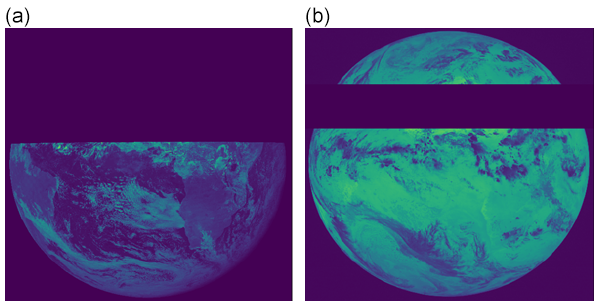
Figure 2. Examples of missing data. Taken from file METEOSAT3- MVIRI-MTP15-NA-NA-19900816133000 and channel WV (a) and file METEOSAT2-MVIRI-MTP10-NA-NA-19840215160000 and channel IR (b) . The pixel values in this figure are the raw digital counts and are mapped using the viridis colour map with 0 repre- sented by dark blue and 255 by yellow